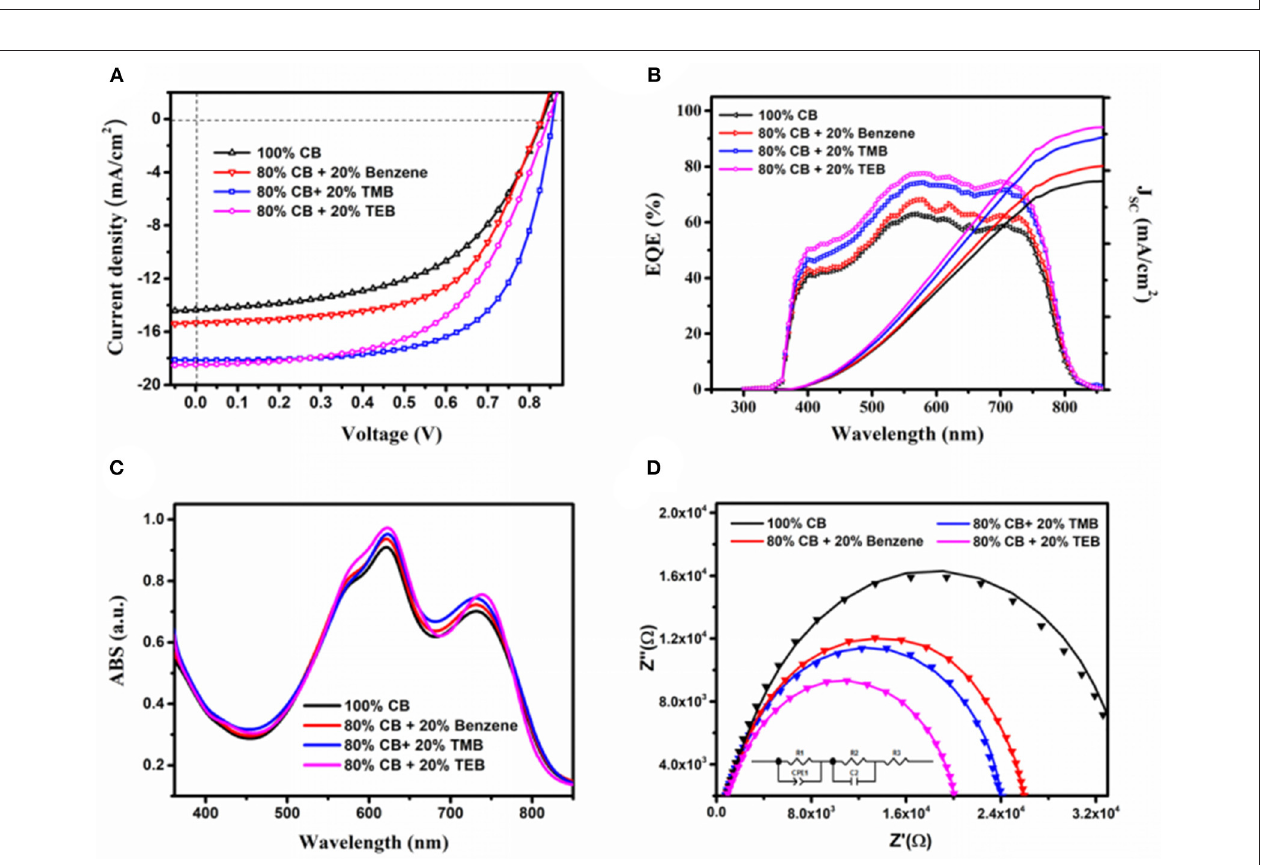
FIGURE 2 | Performance of spray-coated devices by varied solvents. (A) J–V characteristics, (B) EQE curve, (C) absorption spectra, and (D) Cole–Cole plots, solid line represents the fitted line.